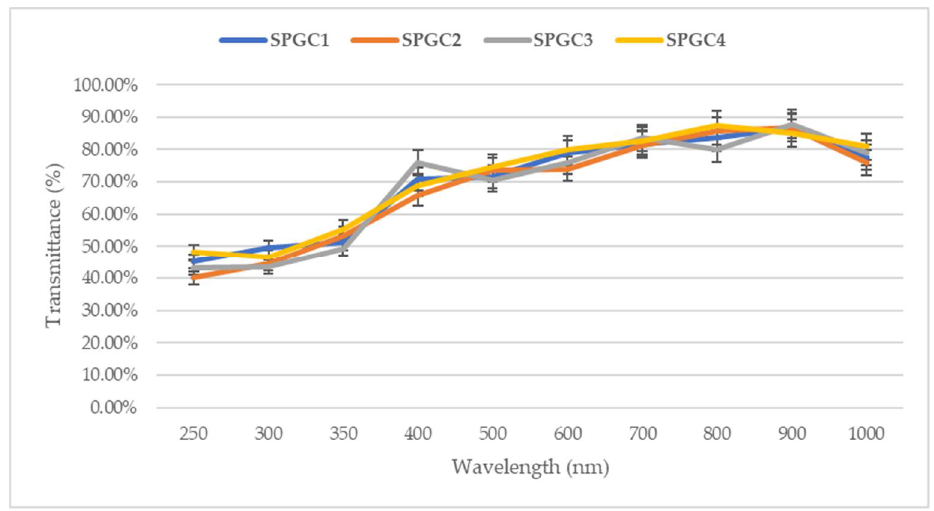
Figure 7. UV–Vis transmittance percentage of starch-based/PVA wound dressings (SPGC1–SPGC4).